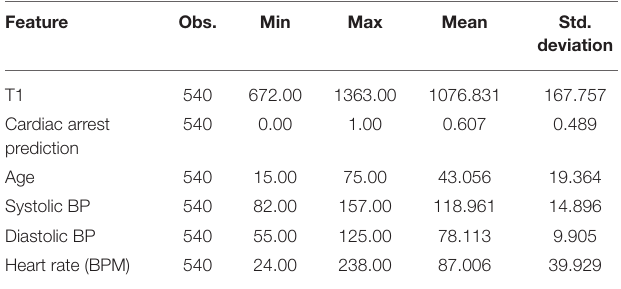
TABLE 5 | Summary of statistical values of risk factors used for 10-year risk model.